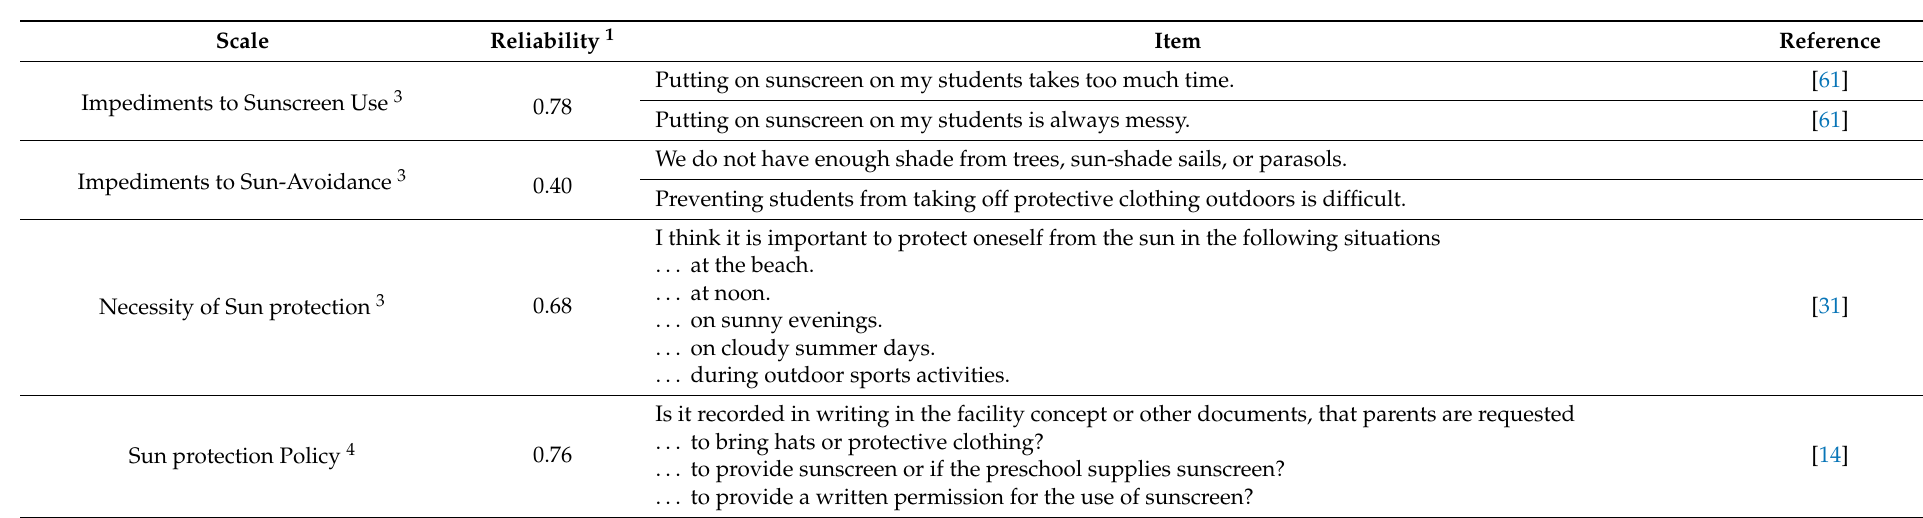
Putting on sunscreen on my students takes too much time. Putting on sunscreen on my students is always